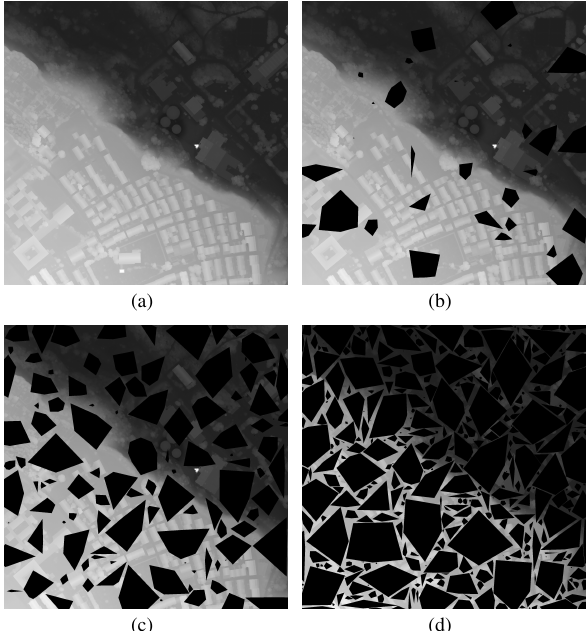
Figure 5. DSM test data (a) full image, (b) 90% valid pixels, (c) 60% valid pixels, (d) 30% valid